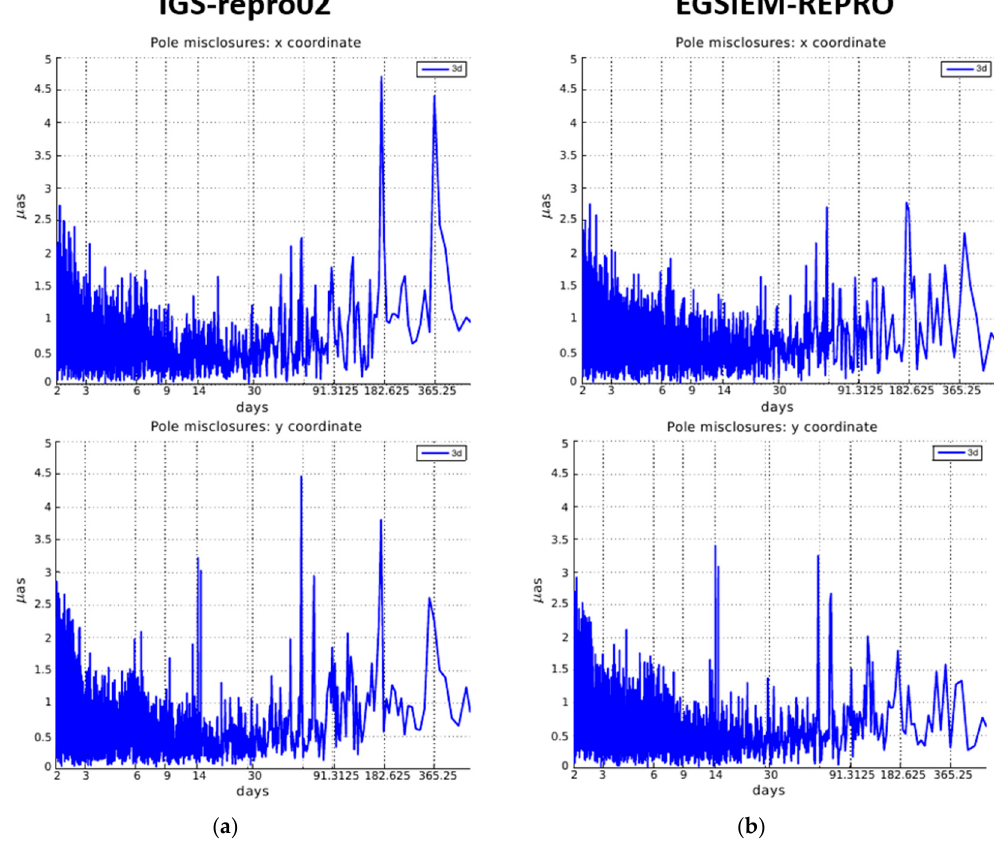
Figure 6. ( a ) Power spectrum of polar motion misclosures for the 3-day solution referring to IGS-repro02. ( b ) Power motion of polar misclosures for the 3-day solution referring to EGSIEM-REPRO. The x coordinates are shown on the top and y coordinates are shown on the bottom. In both cases, the chosen time interval is 2000–2013.